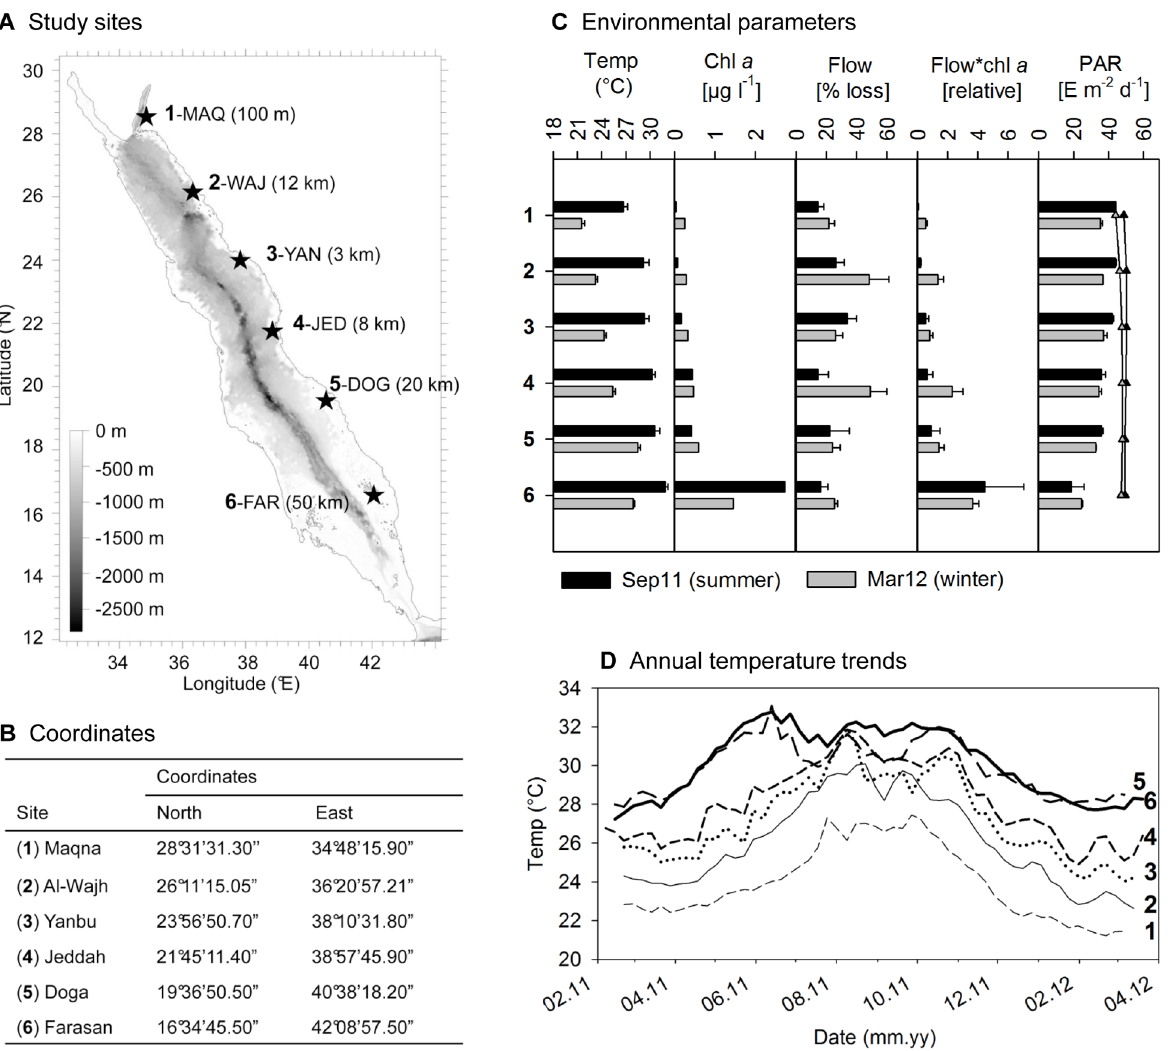
Figure 1. Study sites and environmental conditions in the Red Sea. Sites are labeled from 1 to 6 from north to south. ( A ) Map with study sites and distance from shore in brackets. At site 6, distance from the main land is 50 km, but only 500 m from the island. ( B ) Coordinates of the study sites. ( C ) Environmental conditions at study sites (1 to 6) during summer and winter presented as mean 6 SD. Photosynthetic active radiation (PAR) is also presented for the ocean surface (triangles) in order to demonstrate the effect of nutrients (chl a ) on light attenuation in 5 m depth. Flow*chl a is a relative measure of nutrient flux, for which flow (% gypsum loss) was multiplied by chl a concentration. ( D ) Temperature trends at study sites (1–6) from February 2011 to March 2012 in 5 m